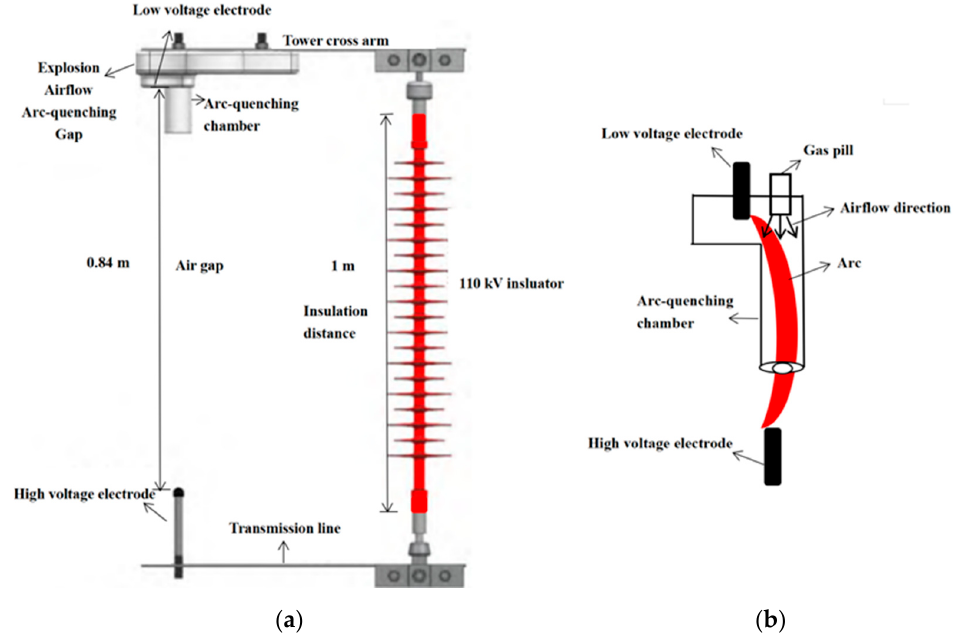
Figure 1. Structural schematic diagram of the device. ( a ) The schematic installation diagram of the device. ( b ) The structure of the arc-quenching chamber